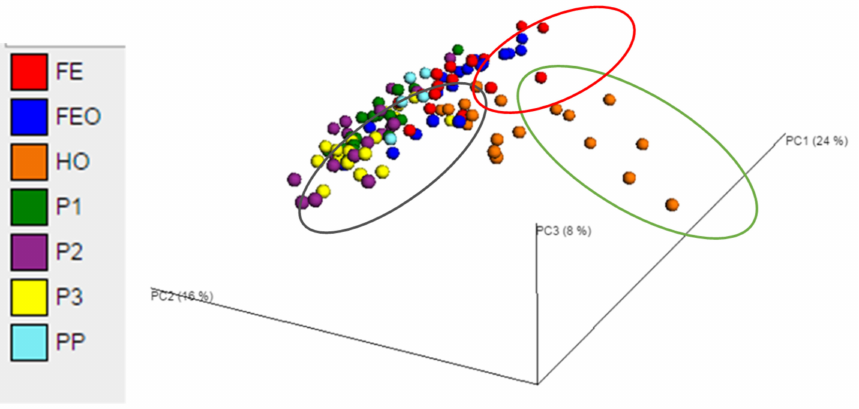
Figure 2. Principal coordinate analysis of the faecal bacterial communities in samples obtained from horses fed pasture and three conserved forage diets on days 5, 6 and 7 of the study-period. Each dot represents the bacterial community structure in a faecal sample from a horse (H1-6) at a certain time point (T120, T144 and T168). Samples are coloured by diet. The first two principal coordinates PC1 (24%) and PC2 (16%) explained most of the variation. The ellipses around the clusters were drawn manually. Diets were labelled as PP (grazing on pasture in paddocks on day 0), P1, P2 and P3 (cut pasture fed in stables during weeks 1, 3 and 5, respectively), FE (chopped ensiled Lucerne and Timothy fed in stables), FE+O (chopped ensiled Lucerne and Timothy fed with whole oats in stables), and H+O (hay fed with whole oats in